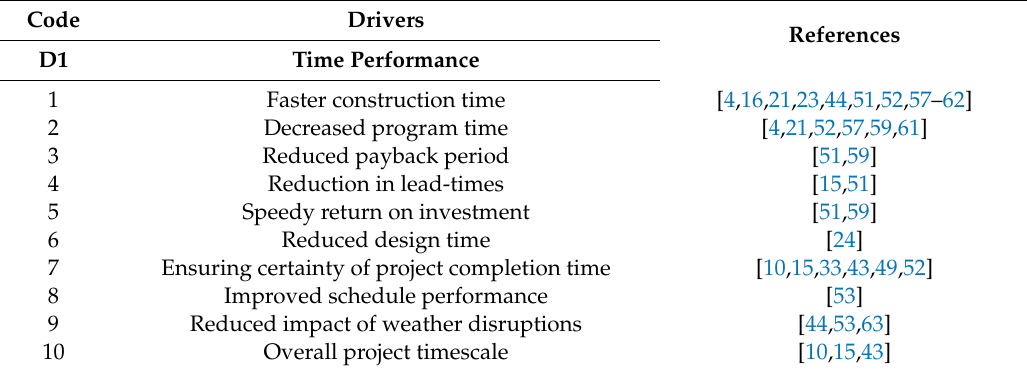
Table 1. Time, cost, and quality drivers of OSC in empirical